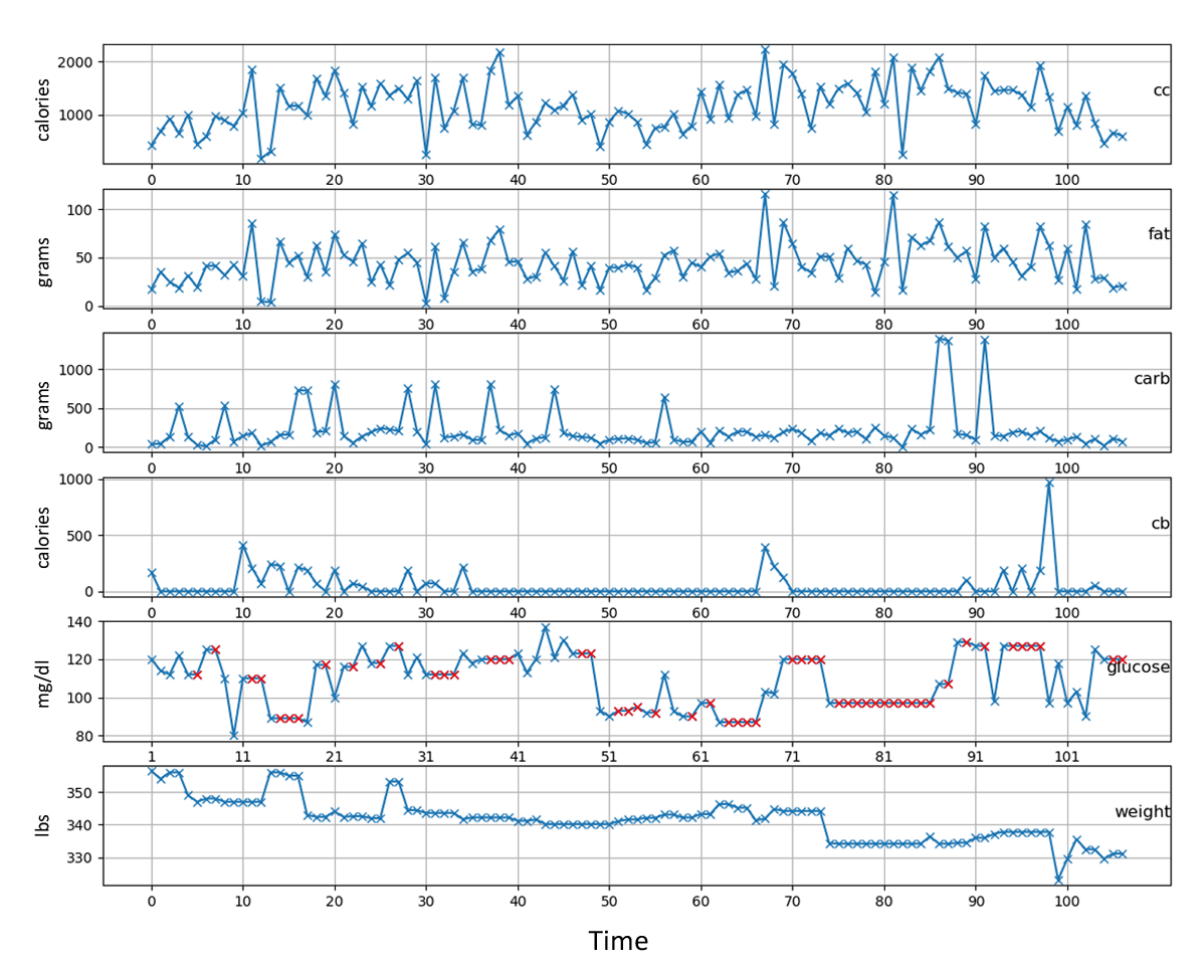
Figure 3. Patient 1 self-recorded data including calories consumed (cc), fat consumed (fat), carbohydratess consumed (carb), calories burned (cb), recorded blood glucose level for the day (glucose), and recorded weight for the day (weight), where blue markers represent original data points and red markers show the imputed data points.